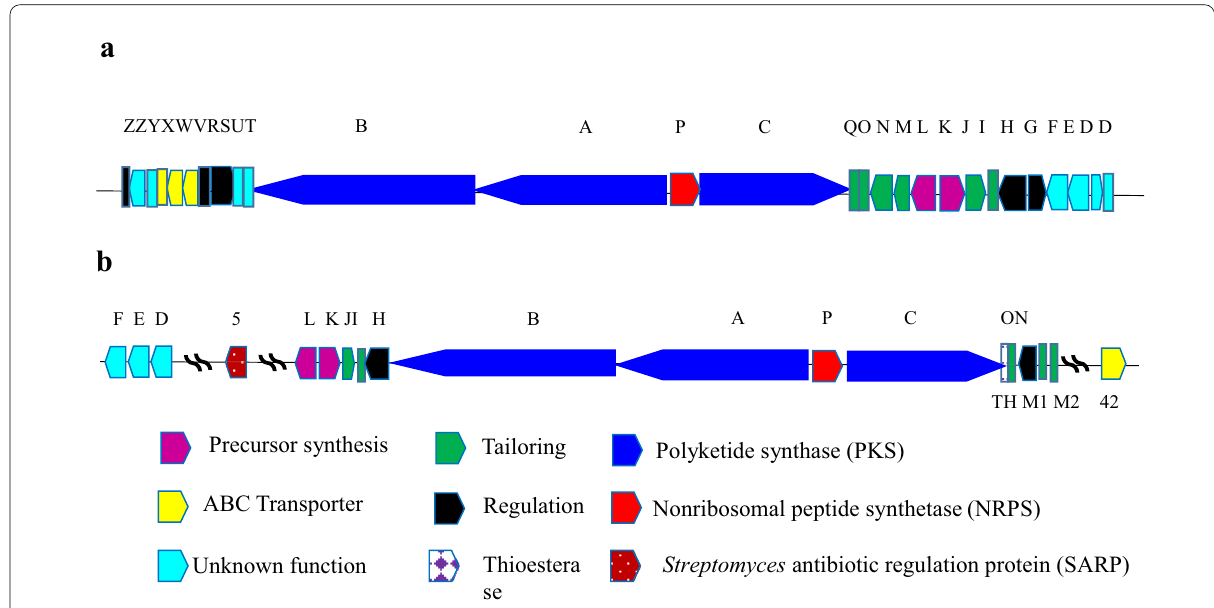
Fig. 3 Biosynthetic gene clusters of rapamycin in Streptomyces hygroscopicus ATCC29253 ( a ), and Actinoplanes sp. N902-109 ( b